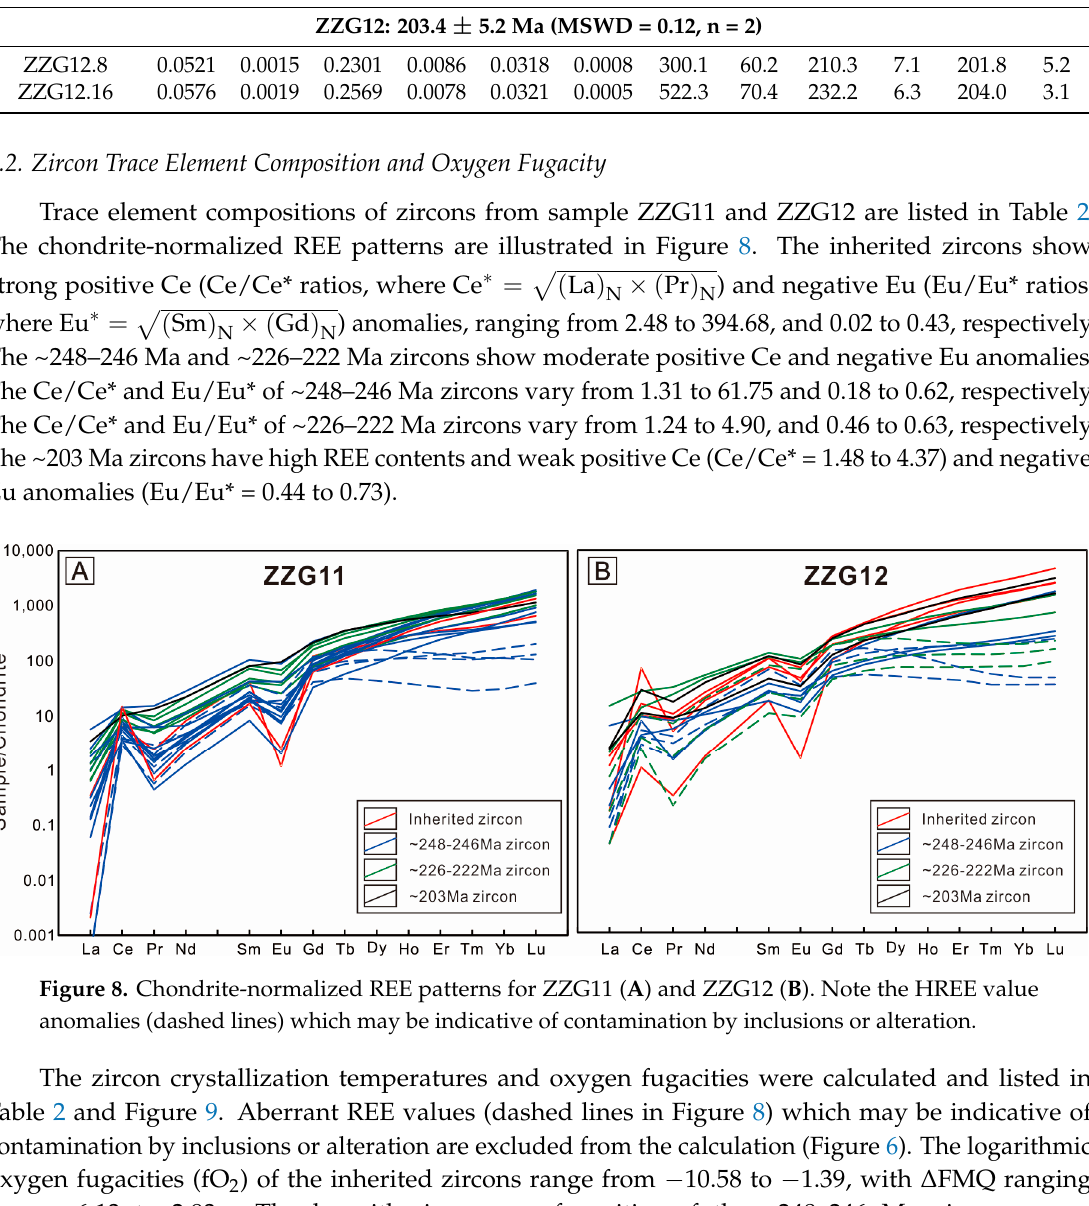
Figure 9. Magma oxygen fugacity for ZZG11 ( A ) and ZZG12 ( B ). 4.3. Zircon Lu-Hf Isotopic Composition